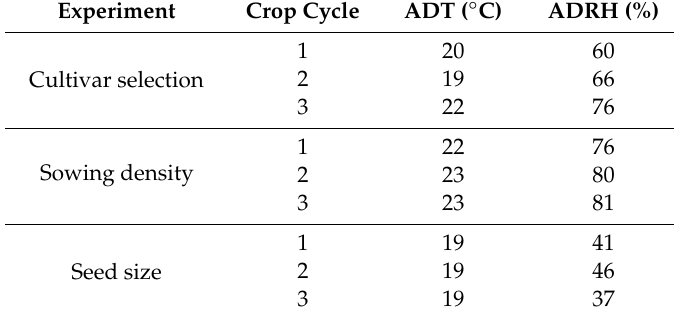
Table 2. Average Daily Temperature (ADT, ◦ C) and Average Daily Relative Humidity (ADRH, %) in three cycles of each